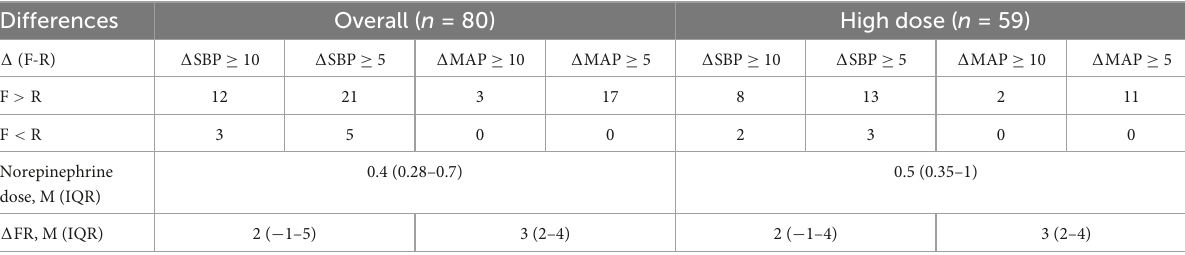
TABLE 3 Number of patients having systolic blood pressure (SBP) and mean arterial pressure (MAP) differences between femoral (F) and radial (R) sites, with cut-off values 5 and 10 mm of Hg. Differences Overall ( n =